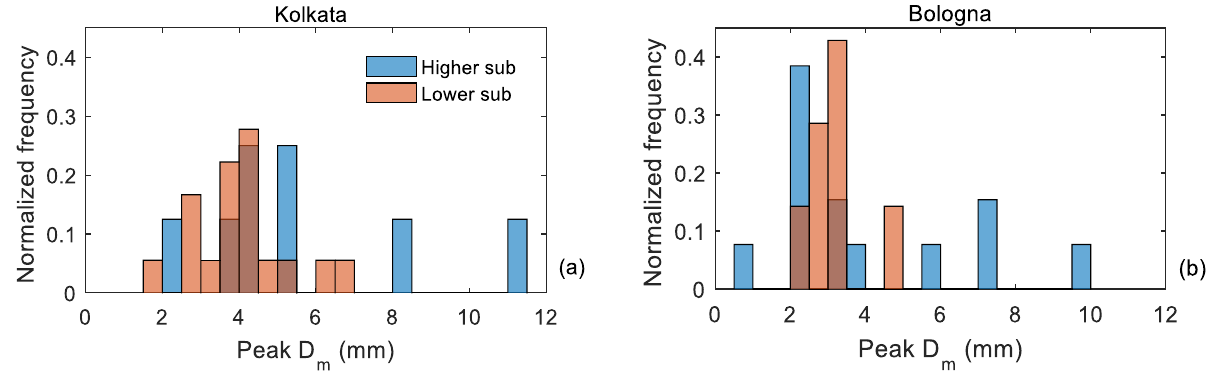
Figure 12. Distribution of the peak D m in events with a lower (than average) and higher (than average) percentage of sub-terminal drops in ( a ) Kolkata and ( b ) Bologna.